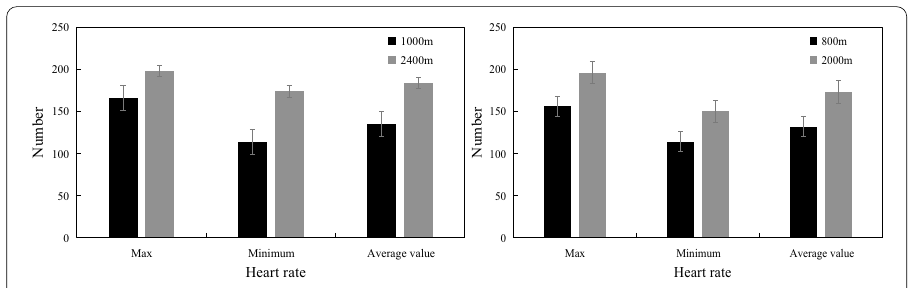
Fig. 7 A list of basic heart rates of boys and